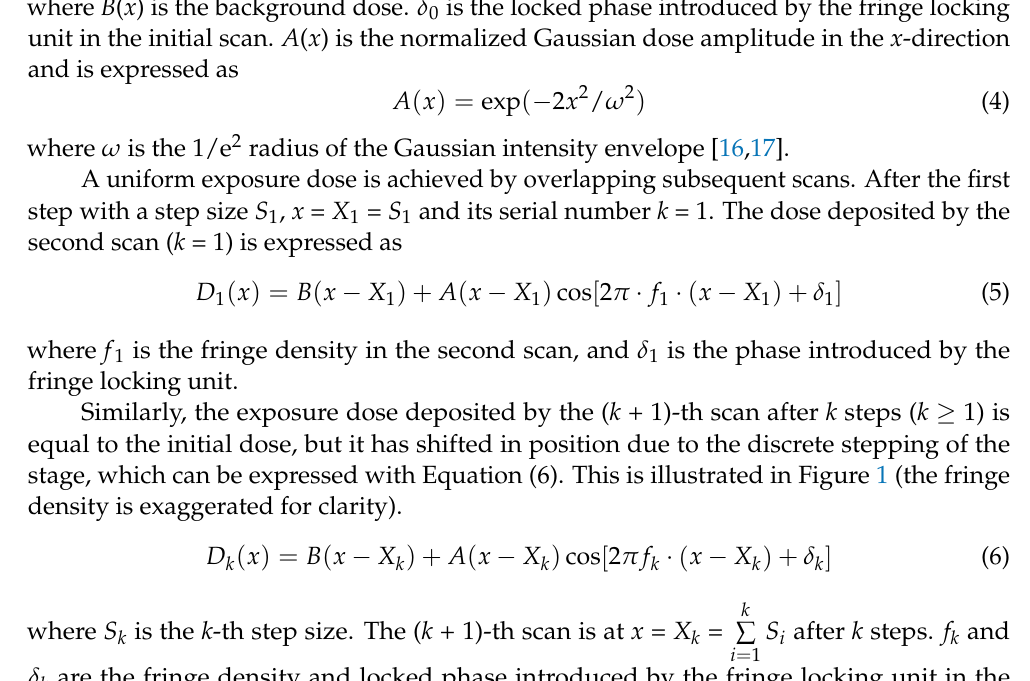
after k steps. f k and δ k